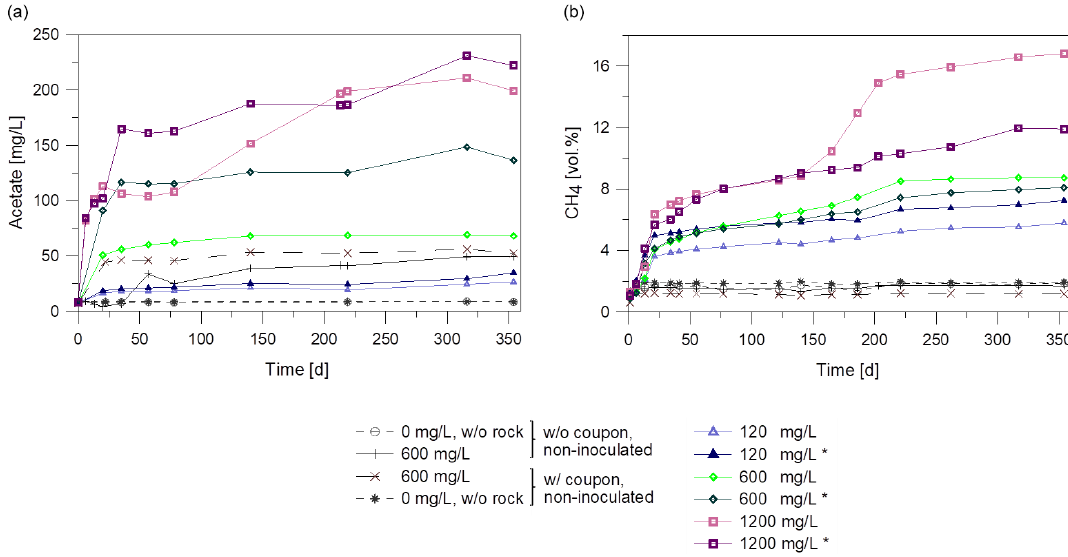
Figure 1. (a) Formation of acetate and (b) of methane over time during microbial degradation of the inhibitor with different initial concen- trations (120 to 1200mg/L) in batch experiments. All batches contained rocks and were inoculated with biofilm except two batches without (w/o) rock and four non-inoculated batches. Batches marked with asterisk (*) were inoculated with the 120mg/L inhibitor preculture. Others were inoculated with 1200mg/L preculture. Two of the non-inoculated control batches contained a coupon (w/ = with) to observe steel- dependent changes. Table 1. Carbon equivalents of the degradation experiment after